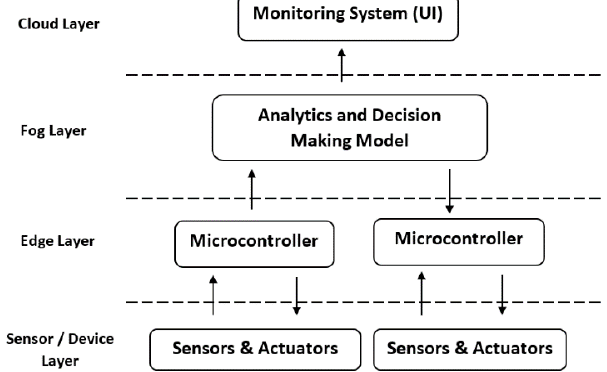
Figure 1. Intelligent smart farming framework for greenhouse management.